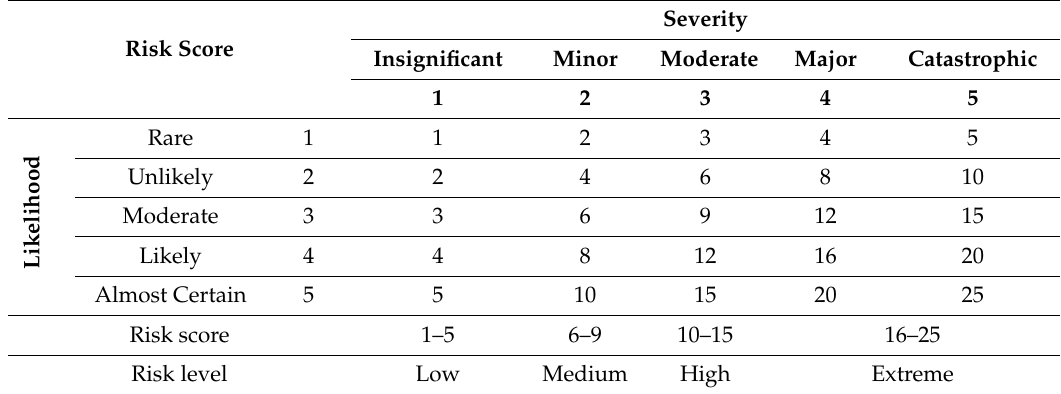
Table 3. Determination of the water security score.